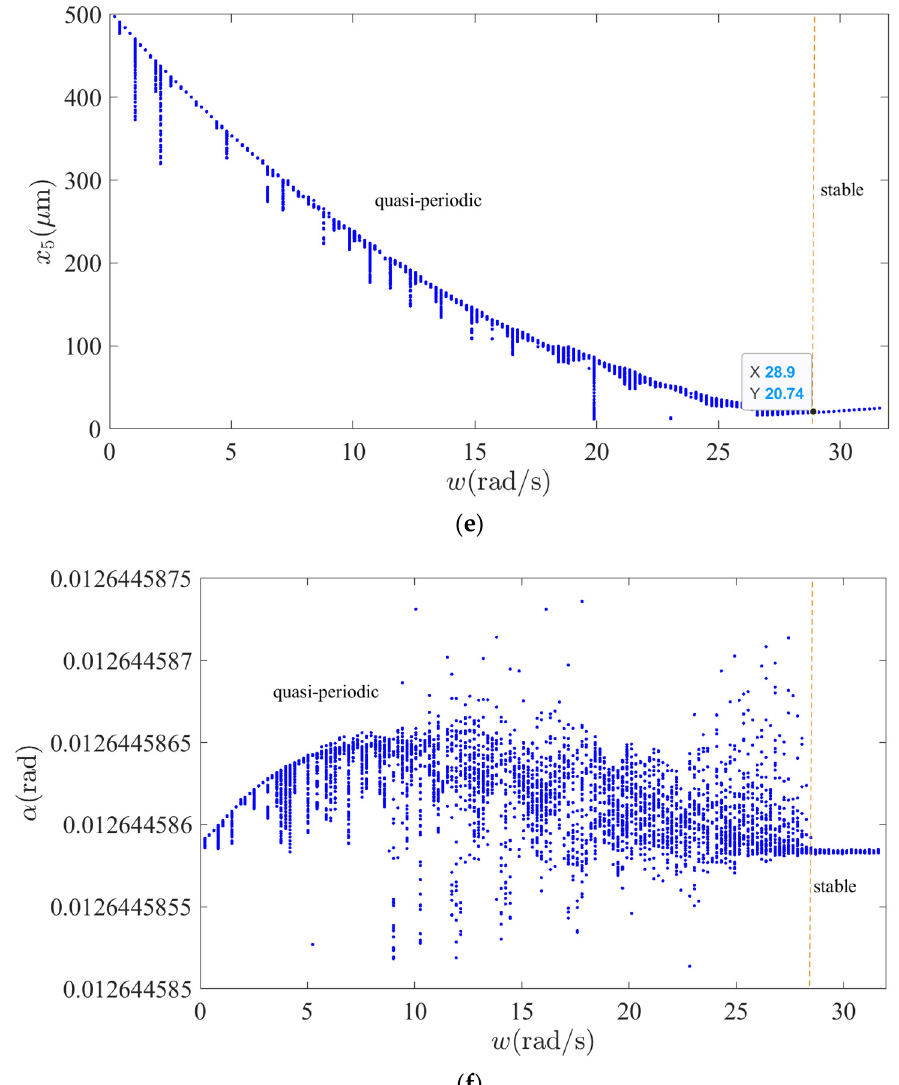
Figure 6. Shafting vibration nonlinear dynamic behavior: ( a ) Generator vibration bifurcation diagram, ( b ) Hydro-turbine vibration bifurcation diagram, ( c ) Upper guide bearing vibration bifurcation diagram, ( d ) Lower guide bearing vibration bifurcation diagram, ( e ) Hydro-turbine guide bearing vibration bifurcation diagram, ( f ) Torsional vibration bifurcation diagram